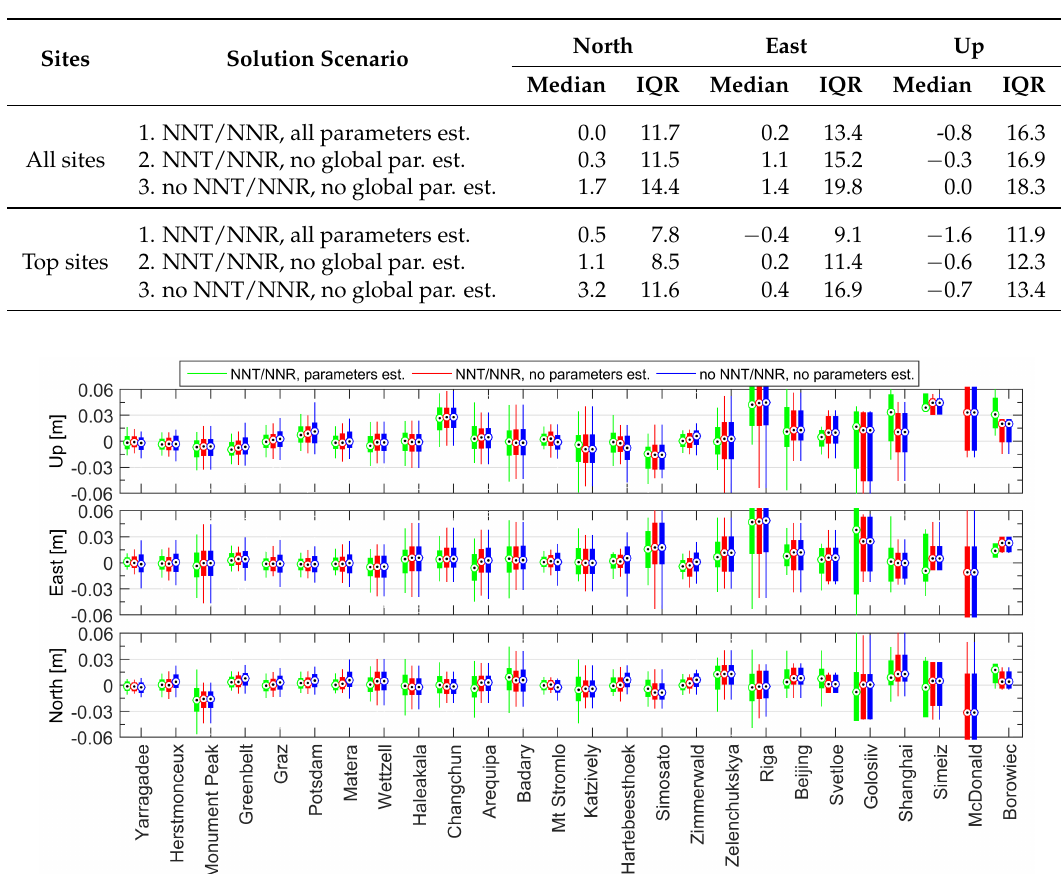
Table 2. SLR station coordinate repeatability for the North, East, and Up components for tested S3A/B solutions for all and top SLR sites (in mm).